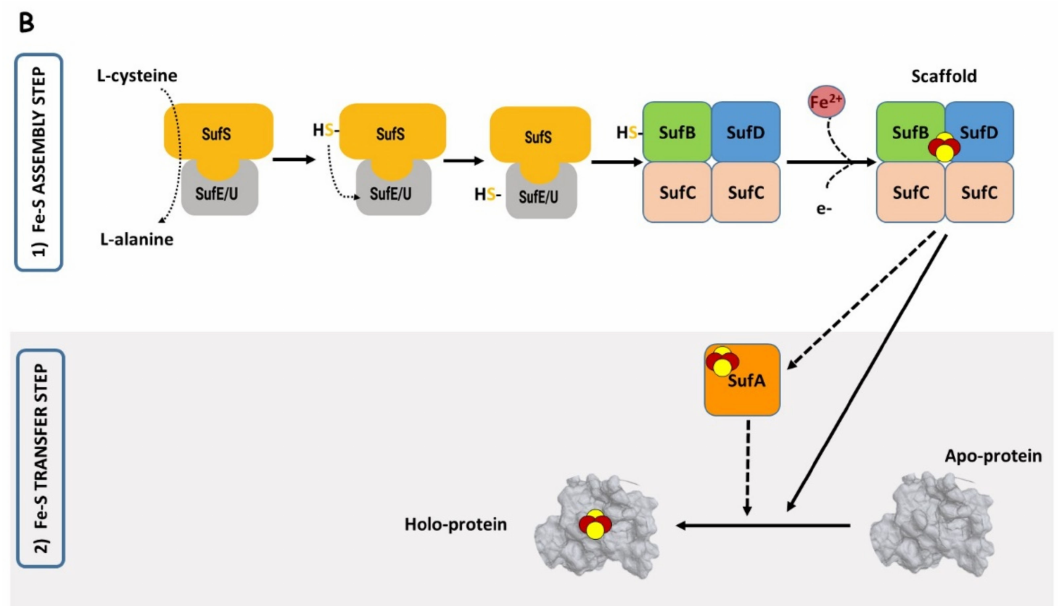
Figure 4. Organization and function of the SUF system. ( A ): genetic organization of suf operons in bacteria and archae. ( B ): role of the Suf proteins in Fe-S biogenesis (mainly from studies on E. coli and B. subtilis SUF systems).